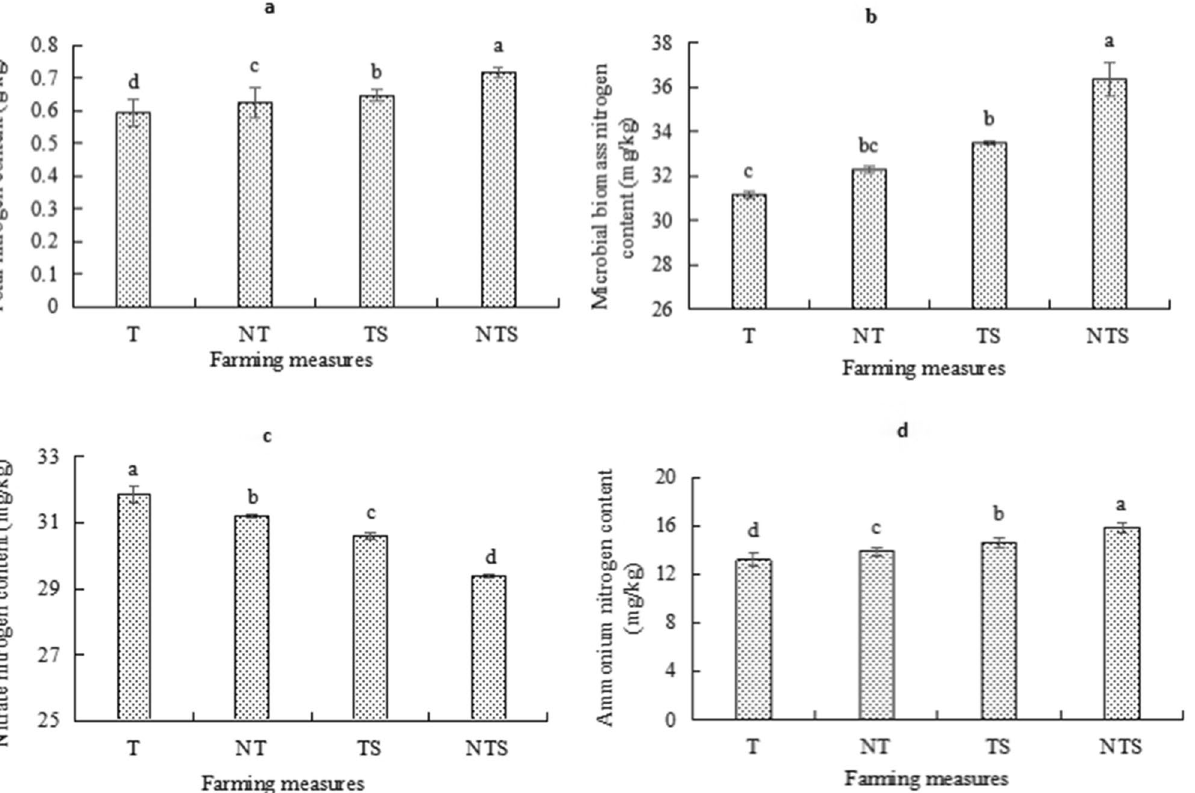
Figure 3. Nitrogen content in 0–10 cm soil of spring wheat under different tillage measures. Different lowercase letters indicate significant differences among different treatments ( P <